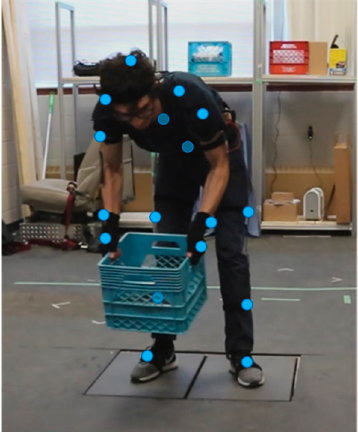
Figure 4. Photo of a subject wearing the Perception Neuron [39] IMC system while performing a lifting task; IMU locations are marked with blue dots.